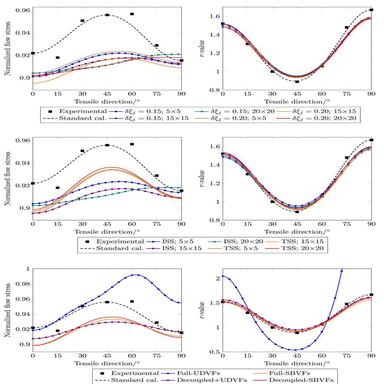
Effect of perturbation parameter j on the prediction of anisotropy of uniaxial yield stress and r-value using different SBVFs virtual mesh size.